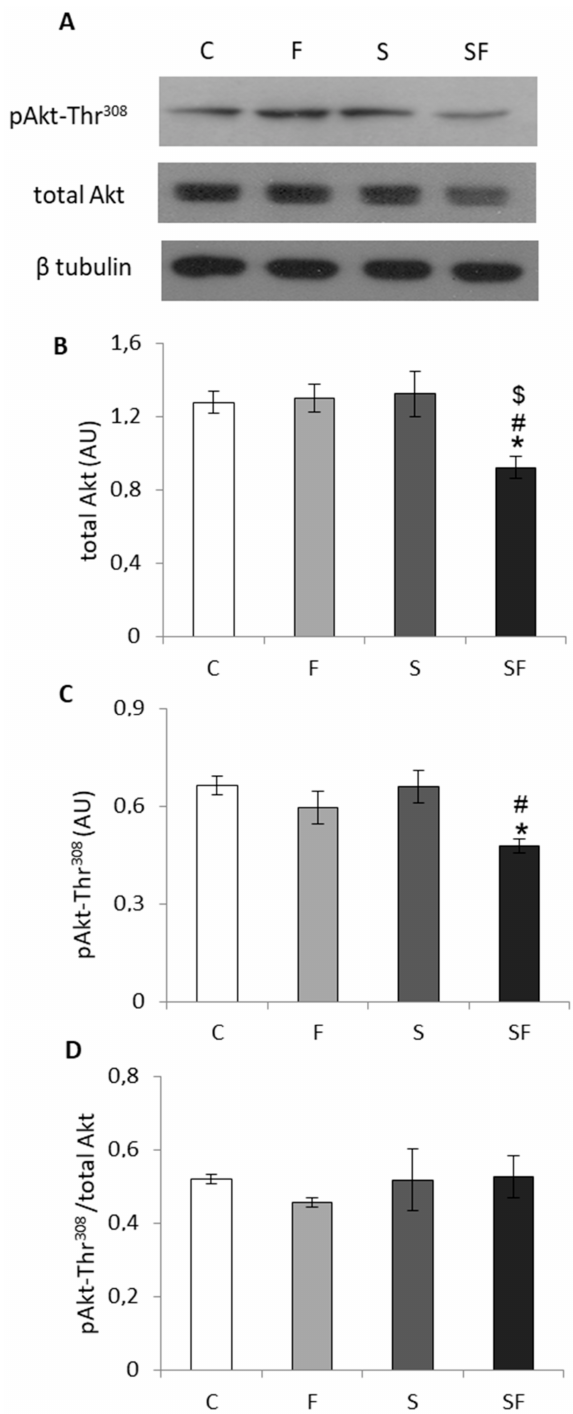
Figure 7. Protein levels of total Akt and its activating phosphorylation in skeletal muscle of control (C), fructose (F), stress (S), and stress + fructose (SF). Representative Western blots ( A ) of protein levels of total Akt ( B ) and pAkt-Thr308 ( C ) in the muscle tissue extracts. The values represent the mean ± SEM ( n = 8–9 animals per group) for each protein normalized to β tubulin expressed in arbitrary units (AU) as well as for the ratio of phosphorylated and total protein ( D ). Significant between-group differences from post hoc Tukey test are given as follows: * p < 0.05, SF vs. C; # p < 0.05, SF vs. F; $ p < 0.05, SF vs. S. Akt—protein kinase